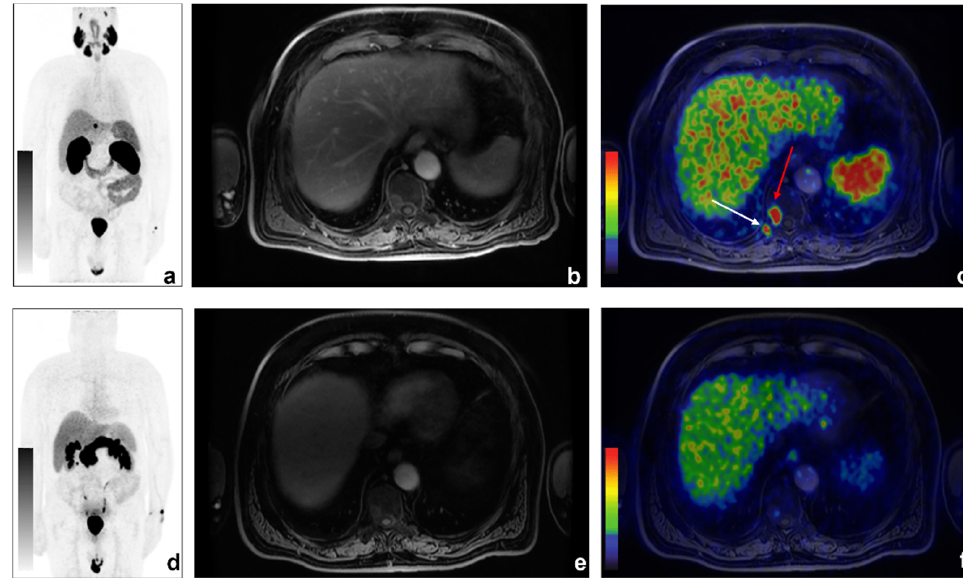
Figure 3. An example of discordant findings between 68 Ga-PSMA and 68 Ga-DOTA-RM2 PET/MRI in bone metastases detection. A 70-year-old patient previously treated with radical prostatectomy for PCa (Gleason 5 + 4; pT3aN0) experienced biochemical recurrence of PCa (PSA = 2.16 ng/mL). 68 Ga-PSMA PET/MRI showed radiotracer uptake in correspondence of right D10 hemisome (( a ): 68 Ga-PSMA MIP; ( b ): axial LAVA-FLEX MRI; ( c ): axial 68 Ga-PSMA PET/MRI, red arrow) and the right posterior tract of the X rib ( c ): white arrow). Non-significant uptake was detected on 68 Ga-DOTA-RM2 PET/MR images ( d ): 68 Ga-DOTA-RM2 MIP; ( e ): axial LAVA-FLEX MRI; ( f ): 68 Ga-DOTA-RM2 PET/MRI) .